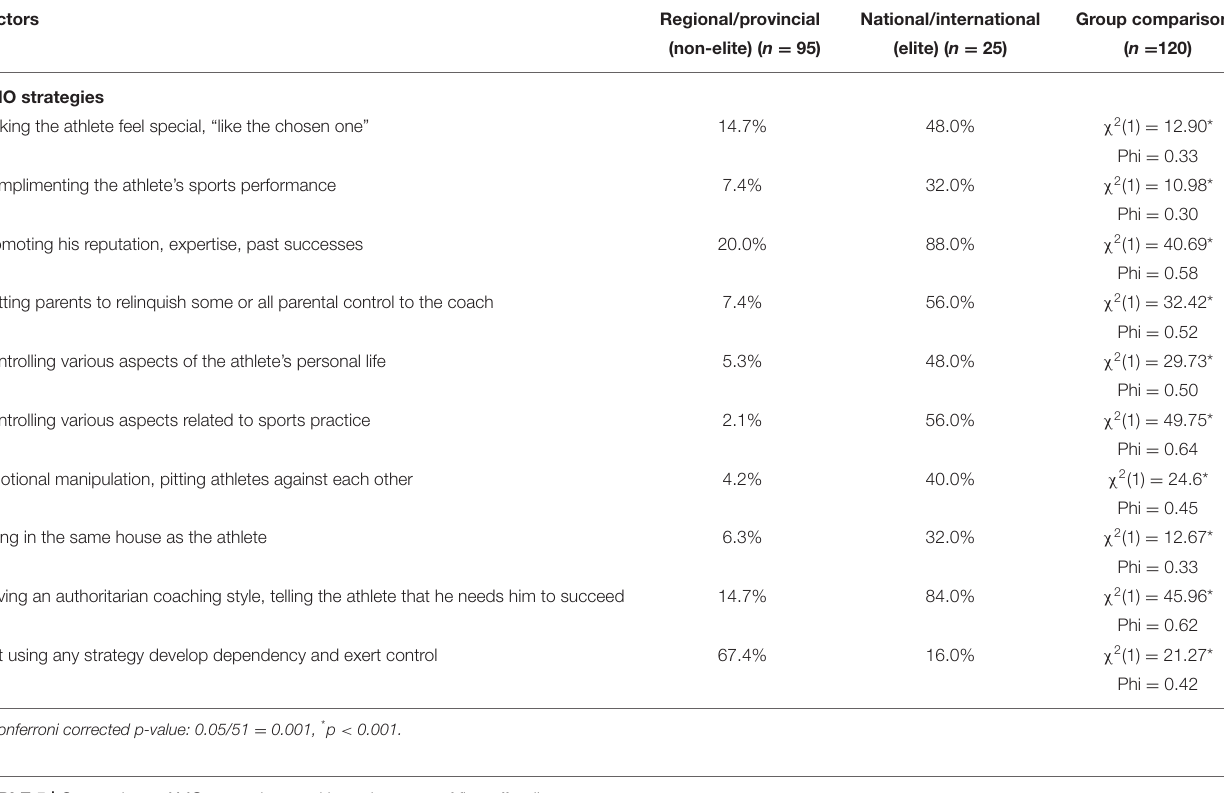
(non-elite) ( n = 95) (elite) ( n = 25) ( n = 120)